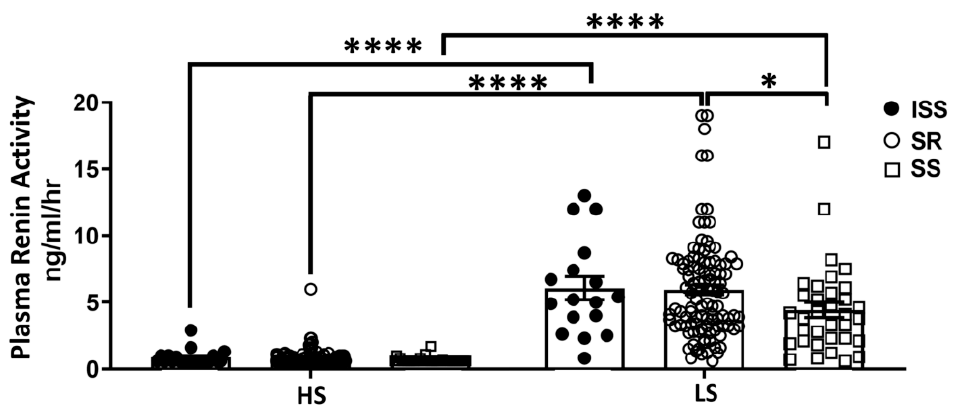
Figure 8. Plasma renin activity level of ISS, SR and SS participants on low and high-salt diets (ISS HS, 0.86 ± 0.12, n = 21; ISS LS, 6.05 ± 0.87, n = 17; SR HS, 0.8 ± 0.55, n = 144; SR LS, 5.94 ± 0.36, n = 108; SS HS, 0.66 ± 0.03, n = 44; SS LS, 4.43 ± 0.57, n = 34; HS vs. LS, p < 0.001, two-way ANOVA, Tukey’s multiple comparisons test). * p < 0.05, **** p < 0.001